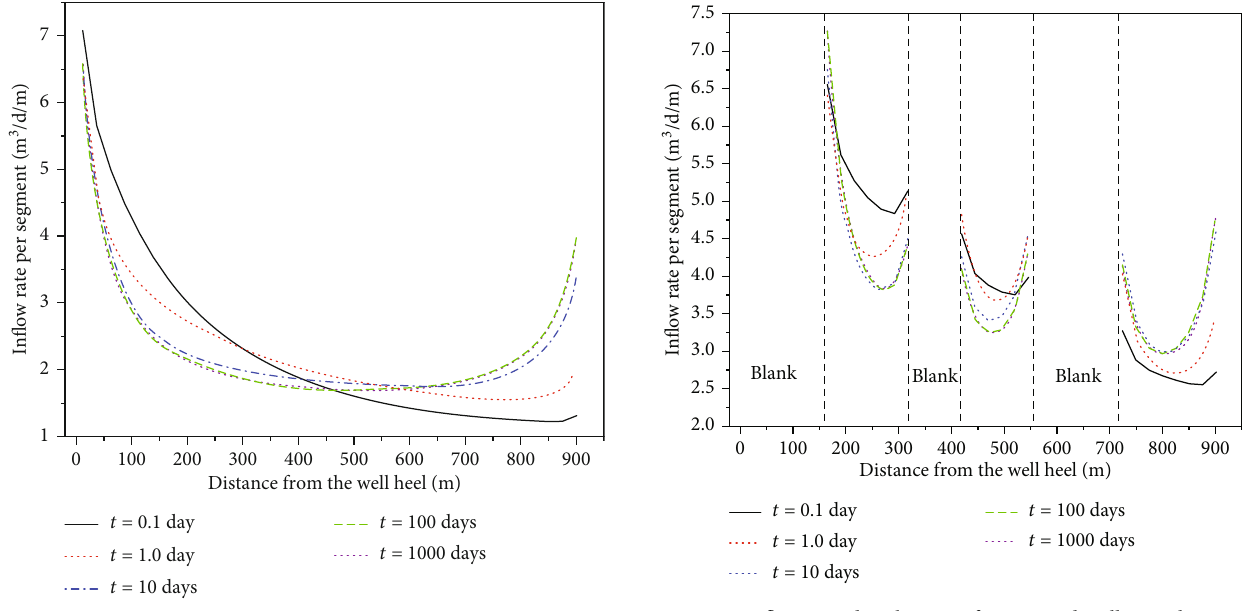
Figure 8: In fl ow rate distribution of completion with di ff erent perforation densities at di ff erent times. Table 4: Parameters of segregated well completion.